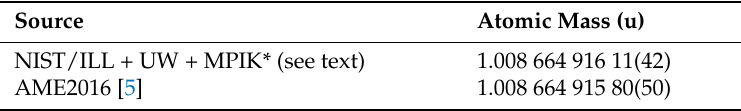
Table 3. Atomic mass values for the neutron.